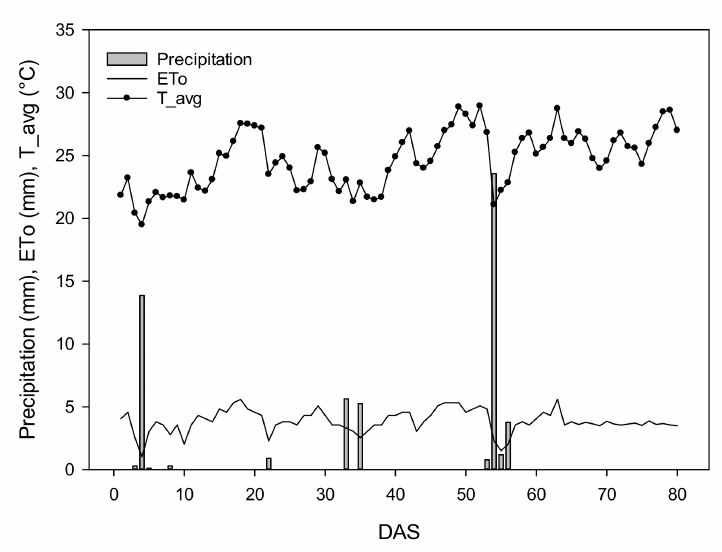
Figure 1. The daily precipitation, reference evapotranspiration (ETo), and average temperature (T_avg) during the crop growing cycle of sweet